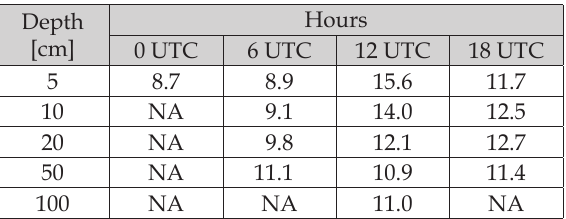
Table 9. Average values of soil temperature [°C] dur- ing the day at various depths in Poznań in 2011–2020. Depth